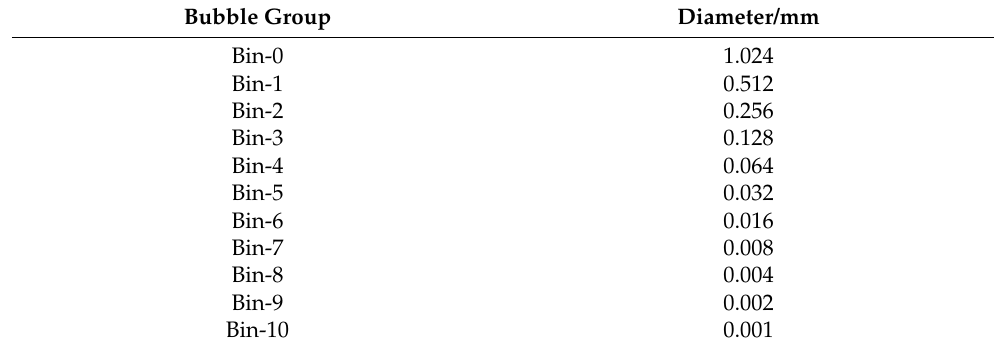
Table 1. Discrete bubble sizes in